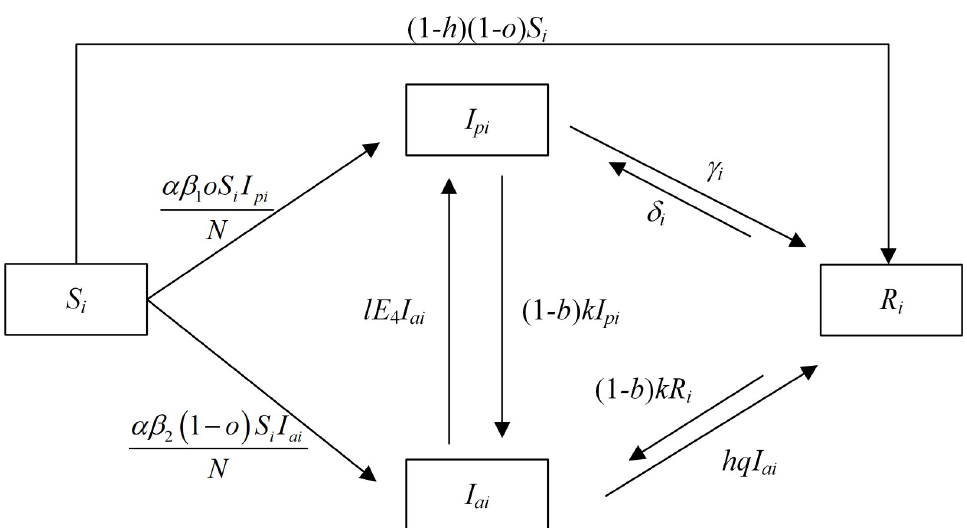
Fig 2. The SIR dissemination model of green retrofit intention among